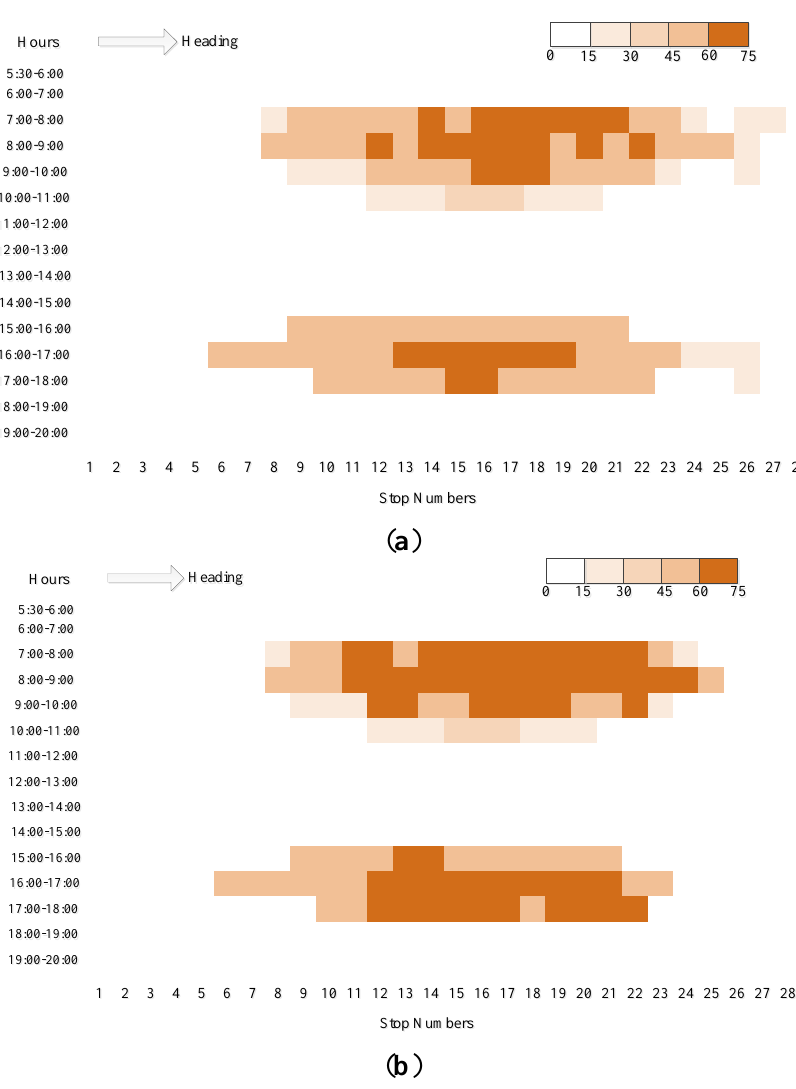
Figure 4. ( a ) Distributions of too short headways of Route 104; and ( b ) distributions of too long headways of Route